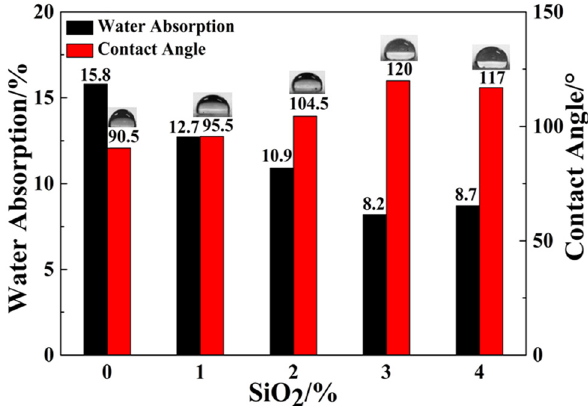
Figure 6: Comparative analysis of water absorption and contact